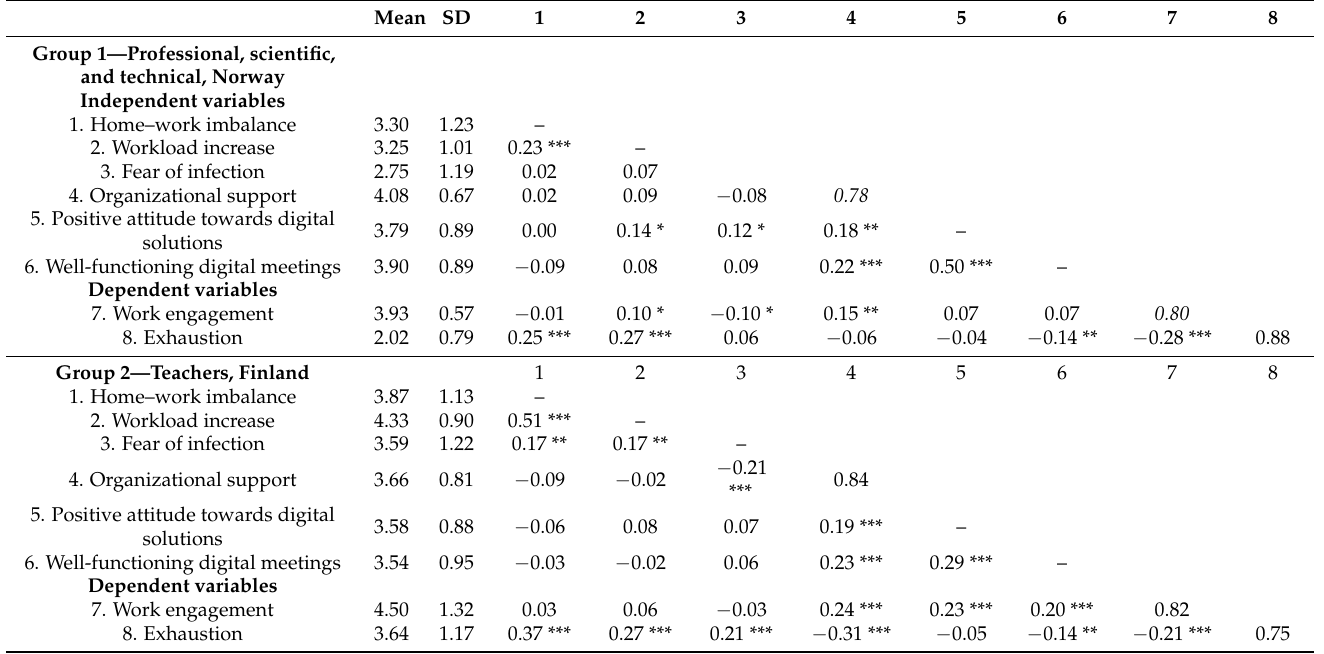
Table 1. Means, standard deviations (SD), and correlations for occupational Groups 1 and 2—Data of professional, scientific, and technical group ( n = 301) and teachers group ( n =